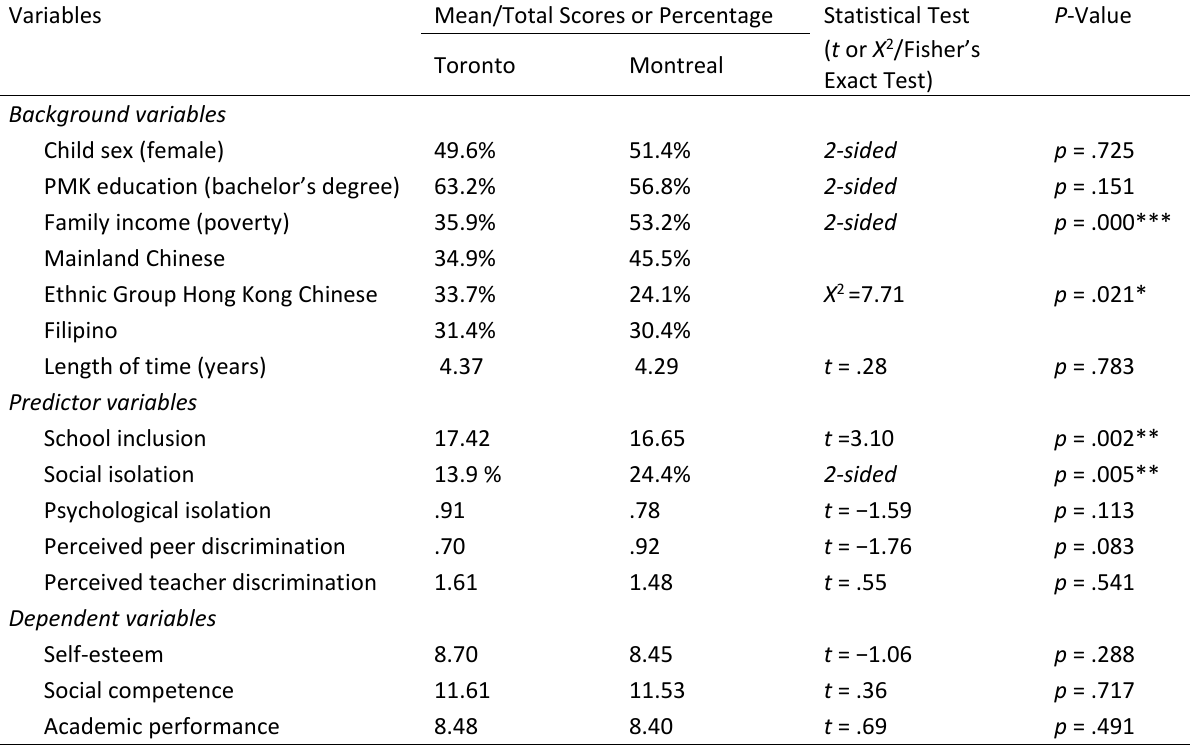
Table 2. Study variables by settlement